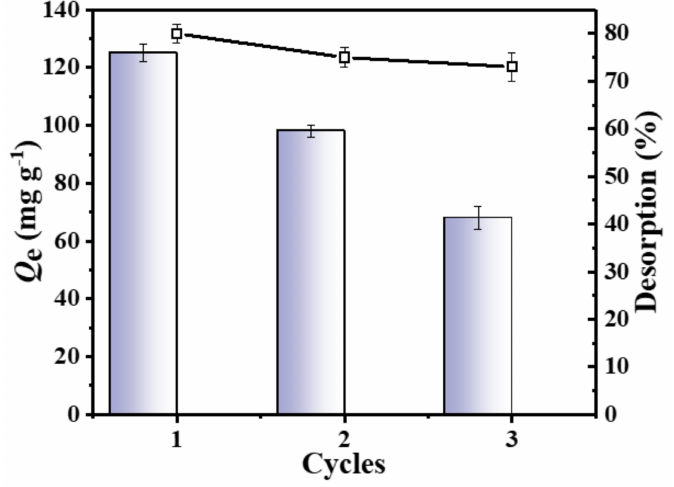
Figure 11. Adsorbed amounts of 3,4,5-TCP (down) and desorption efficiency (up) of the C–O/W microcapsules over 3